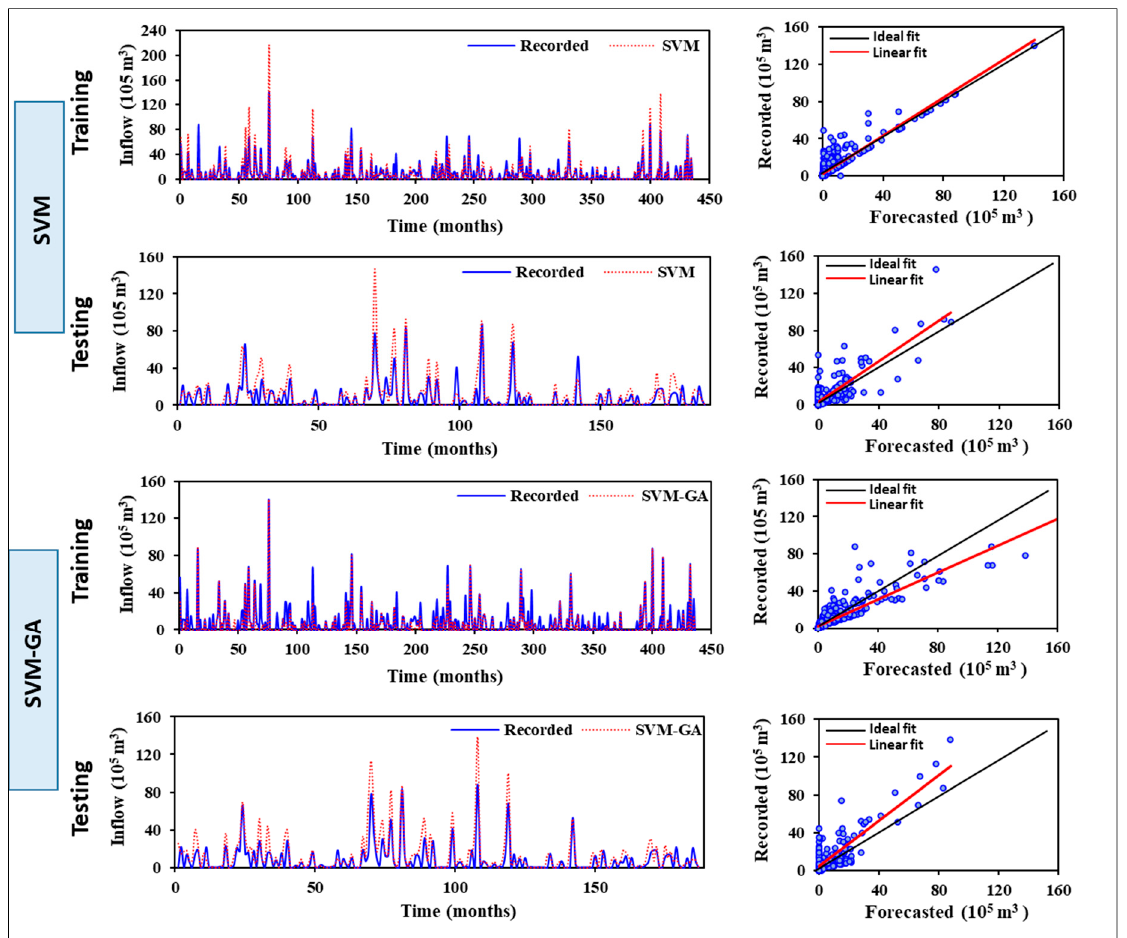
Figure 9. Training and testing results of the simulated monthly inflow based on SVM and SVM-GA models.